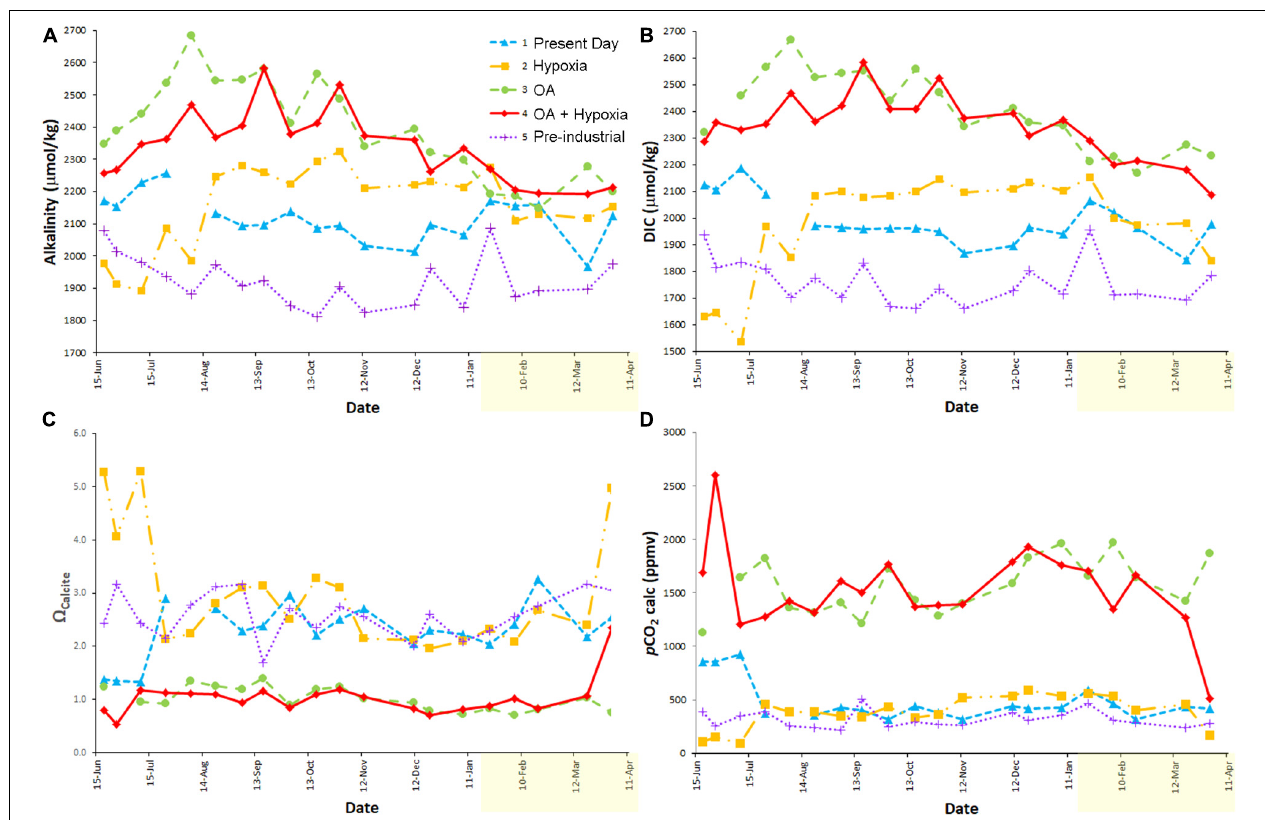
FIGURE 2 | Measured [alkalinity (A) , DIC (B) ] and calculated ( (cid:127) calcite (C) ; p CO 2 (D) ] carbonate chemistry parameters over the full experiment. The temperature increase occurred on 14 January 2014 (yellow shading on x -axis is warmer period). Issues with Treatments 1 and 2 were rectified as noted in text. Treatment 1 (blue) is Present Day; Treatment 2 (orange) is Hypoxia; Treatment 3 (green) is OA; Treatment 4 (red) is OA + Hypoxia; Treatment 5 (purple) is